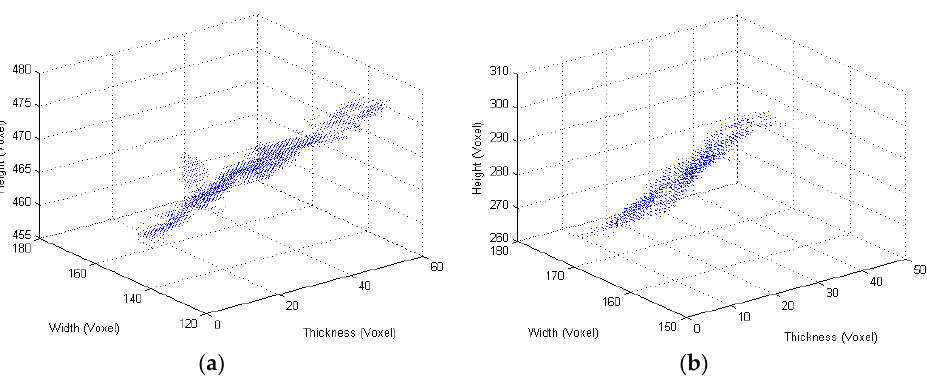
Figure 7. Cracks detection results (10 voxels ≈ 7 mm) without restriction on the investigation box (Ψ = 0.5): ( a ) seed voxel #1; ( b ) seed voxel #2.